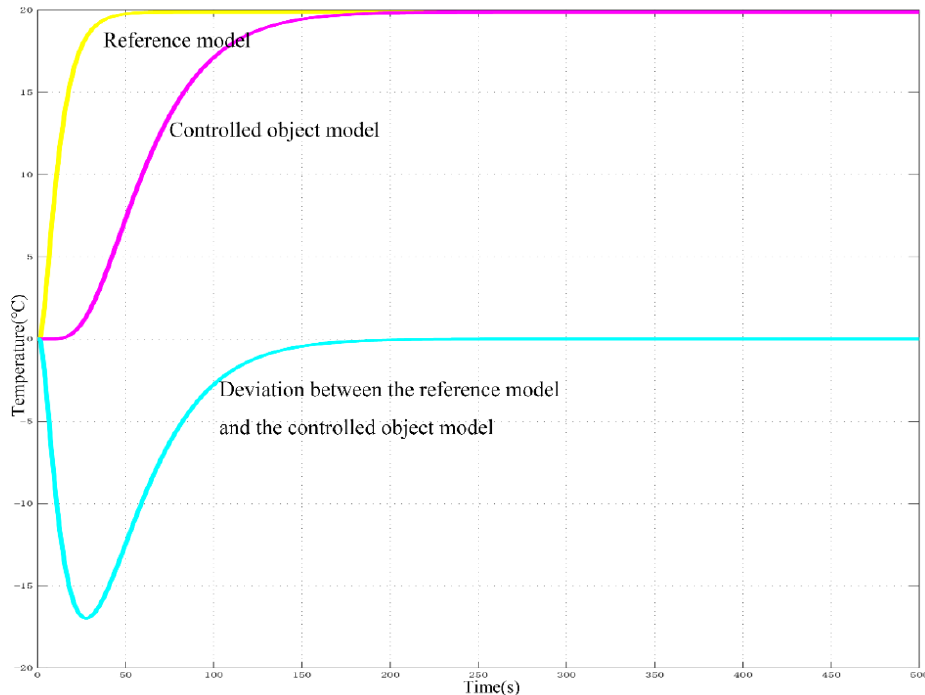
Figure 21. Output curve comparison in terminal control system.